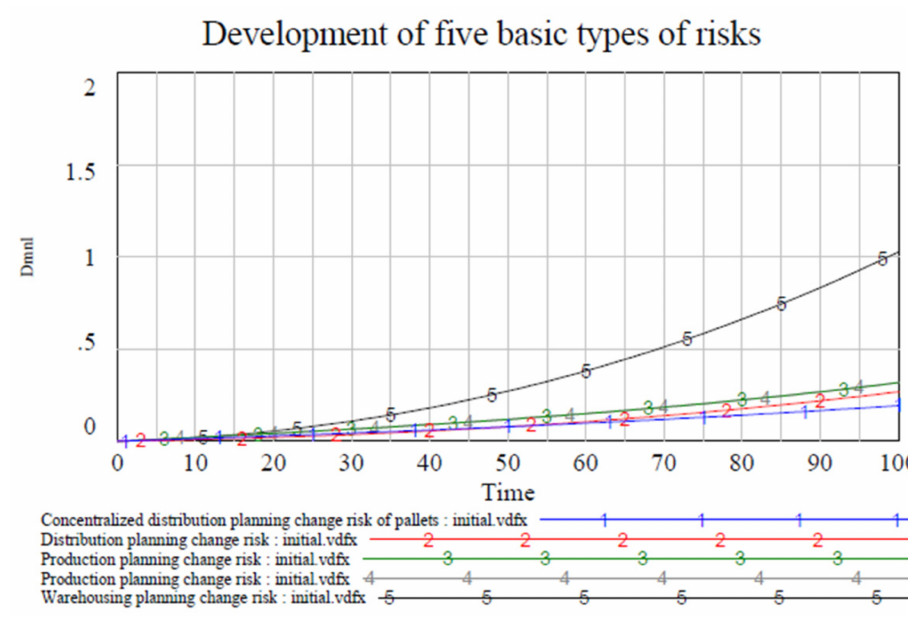
Figure 5. Risk consequence trend chart.